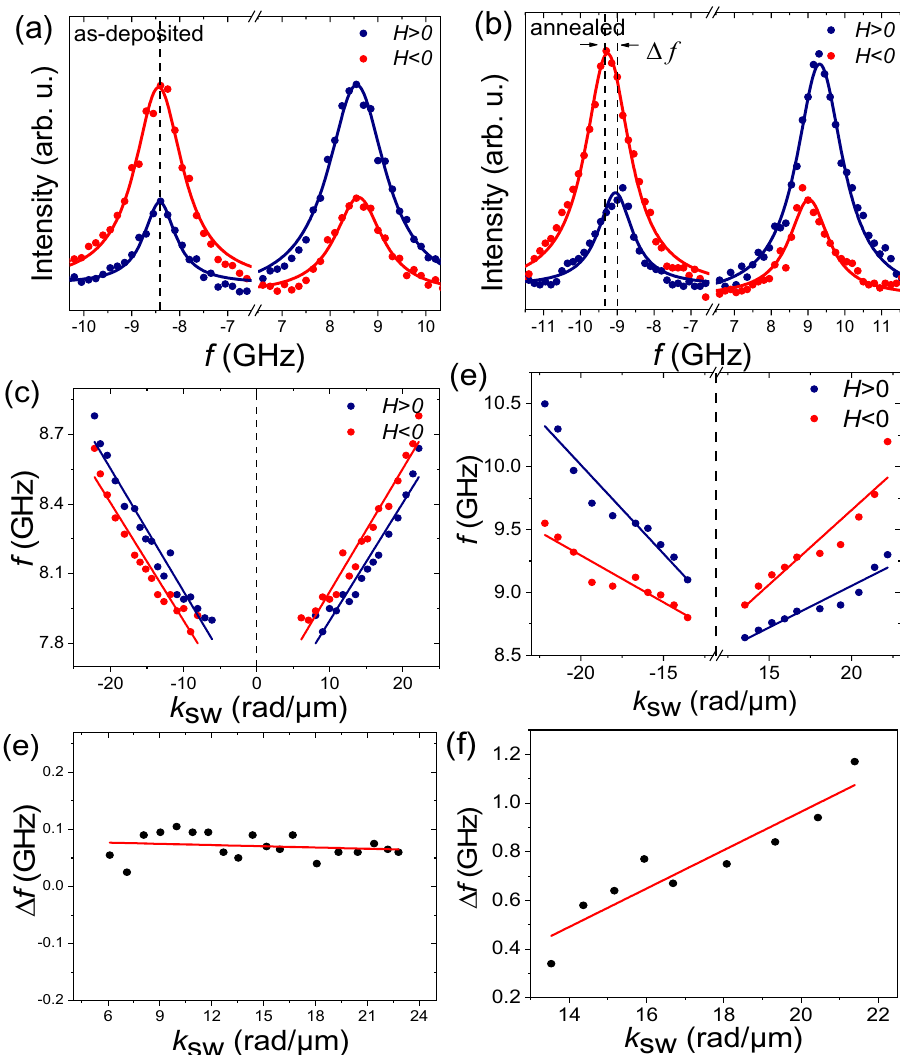
Figure 2. Results from the Brillouin light scattering spectroscopy. ( a – b ) The measured BLS spectra of the SWs having wave number of k sw = 20.44 rad/ μ m in the presence of two different applied field values ( µ 0 H = ± 50 mT) for the as-deposited and annealed samples, respectively. Symbols refer to the experimental data and solid lines are the Lorentzian fits. ( c – d ) The measured dispersion relation of the SWs including the Stokes (S) and anti- Stokes (AS) peaks for the as-deposited and annealed samples respectively. Symbols and solid lines correspond to the experimental data and linear fits results. ( e – f ) The frequency difference (cid:31) f between the counter-propagating SWs as a function of the wave vector for the as-deposited and annealed samples,